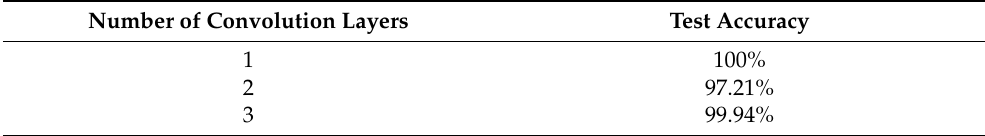
Table 5. Comparative experimental analysis of convolution layers.